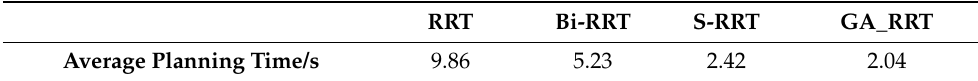
Table 4. Calculation